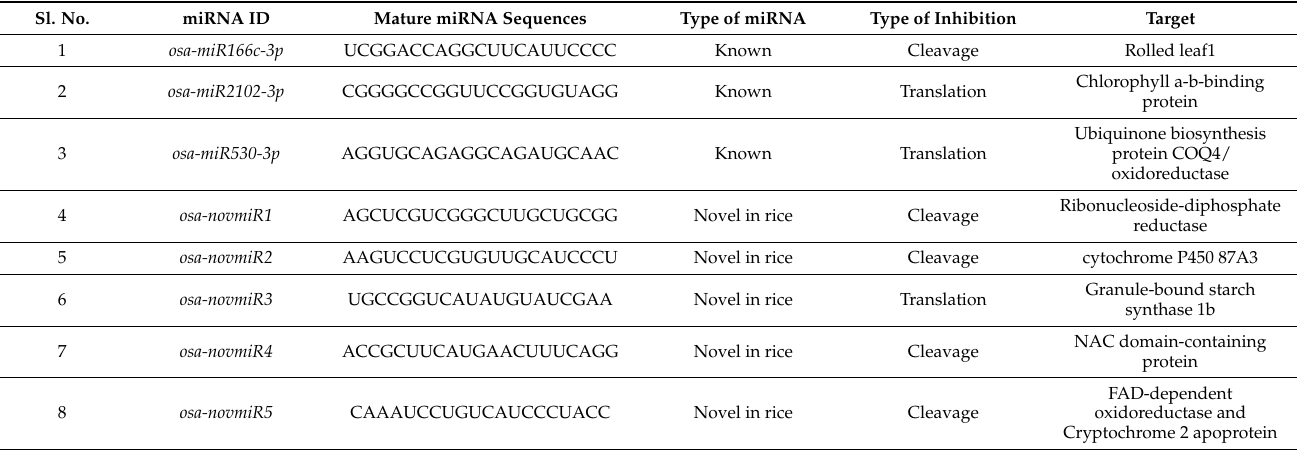
Table 3. List of differentially expressed miRNAs identified through small RNA sequencing selected for